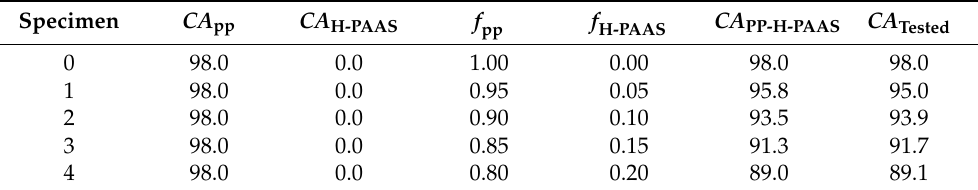
Table 1. Static contact angles of specimens.